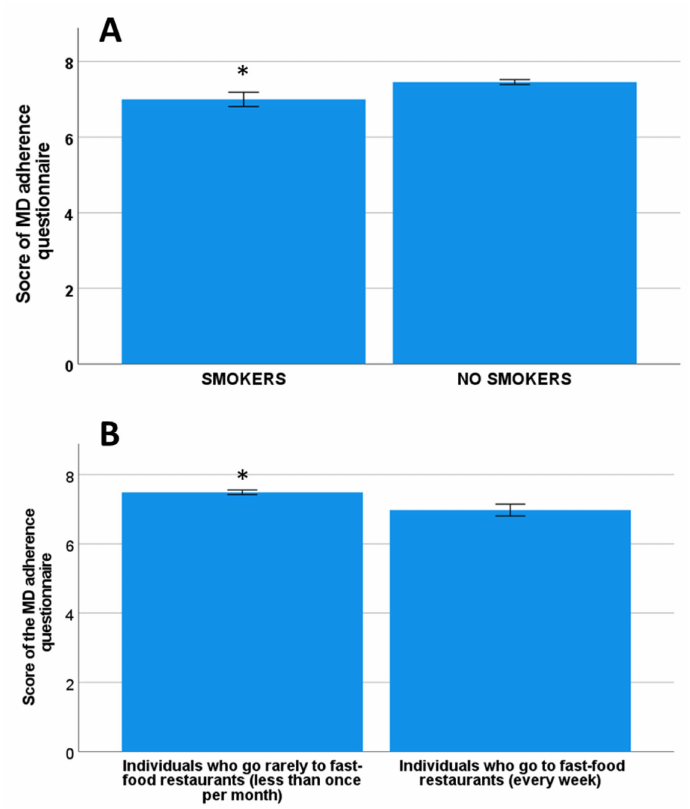
Figure 1. Mean score of MD adherence questionnaire in smokers and non-smokers ( A ) and those individuals having or not having main meals in fast-food restaurants ( B ). * p <